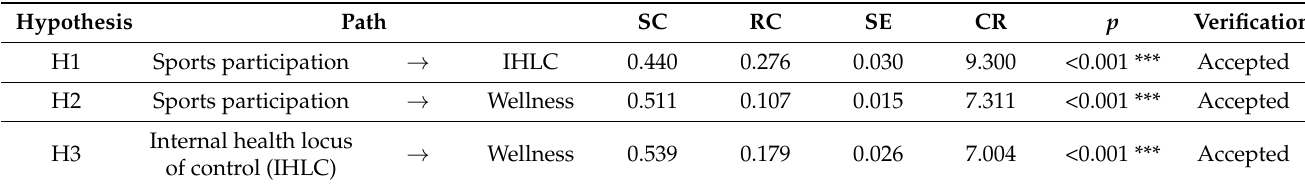
Table 10. Results of path